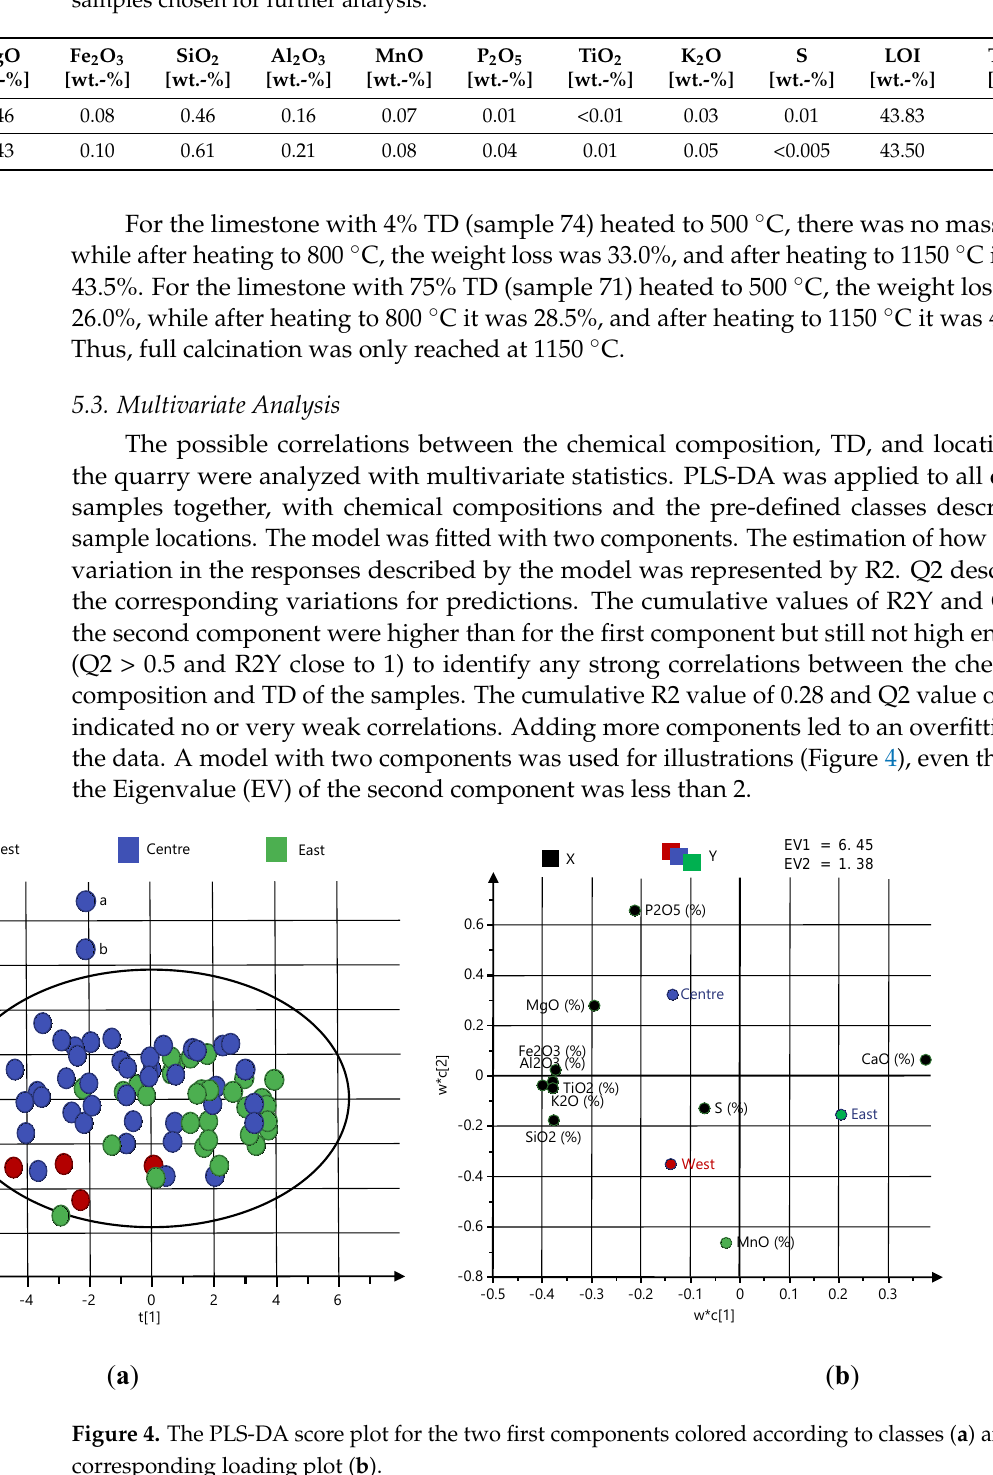
Table 3. The XRF chemical compositions and thermal decrepitation values of two Jutjärn limestone samples chosen for further analysis.